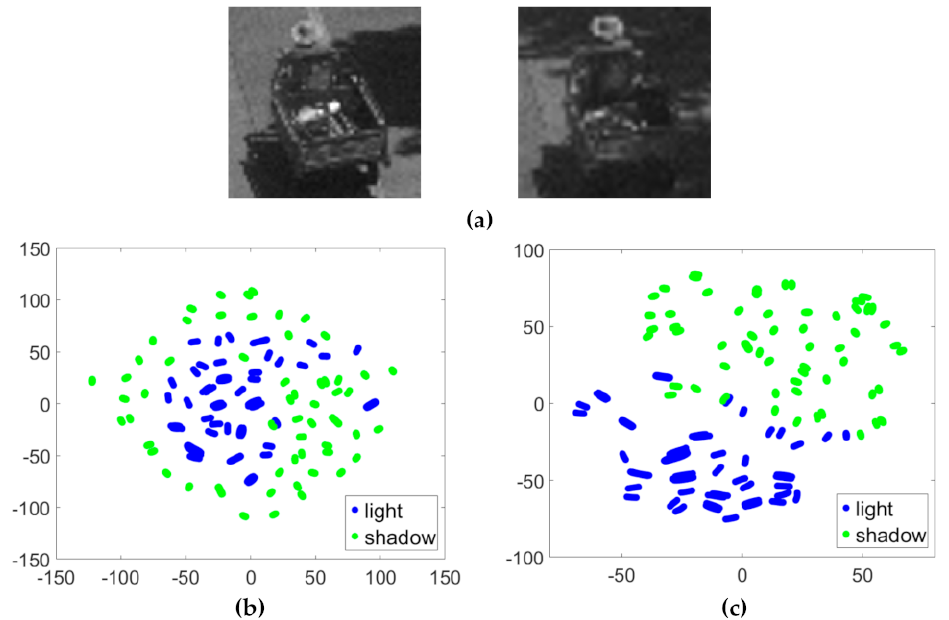
Figure 6. The scatter-plot visualization representations of the HSI and RGB datasets with the challenge of illumination variation using t-SNE. ( a ) Sample images of the dataset with illumination variation (object in light and object in shadow). The electric car is subjected to light changes during driving. ( b ) Visualization of the HSI dataset. ( c ) Visualization of the RGB dataset. The x axis and y axis represent the two feature values of the data in two-dimensional space, respectively. There are two states (light and shadow) of the same object in two datasets, each of which is represented by a particular